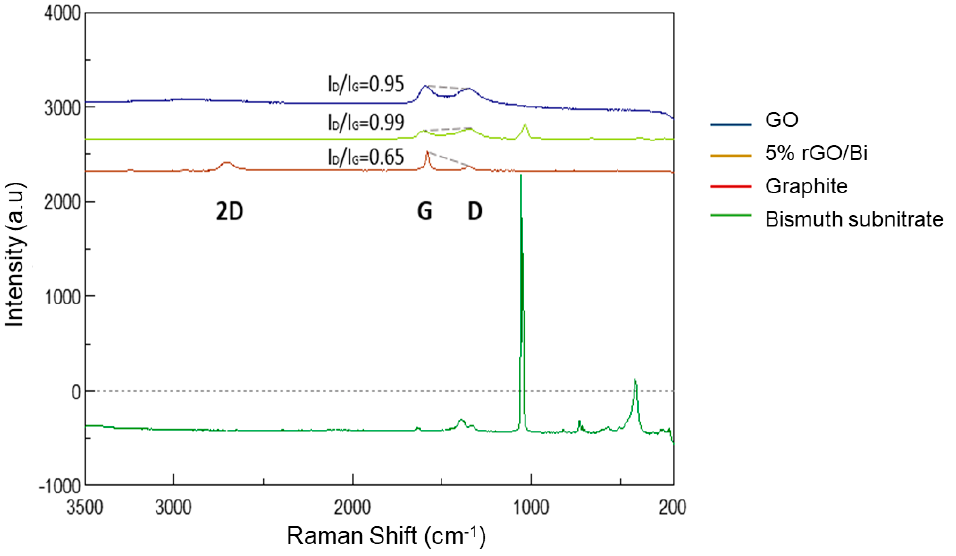
Figure 6. Raman spectra of GO, 5%rGO / Bi, graphite, and bismuth Figure 6 . Raman spectra of GO, 5%rGO/Bi, graphite, and bismuth subnitrate.